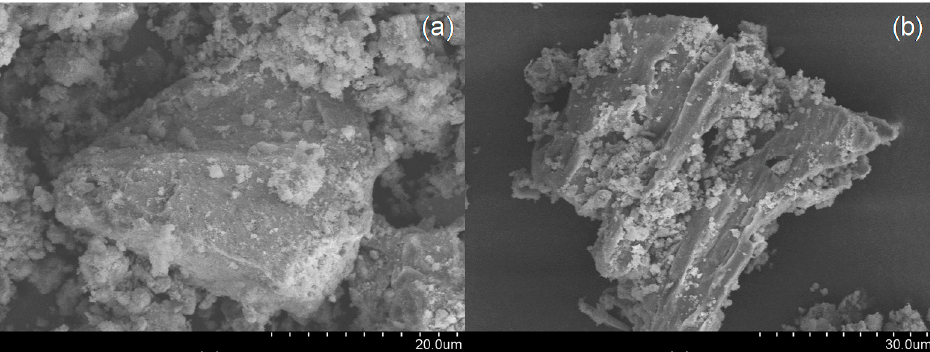
Figure 14. SEM images of the ore ( a ) before and ( b ) after caustic digestion (digestion condition: 50 wt% NaOH and 145 °C for 3 h).